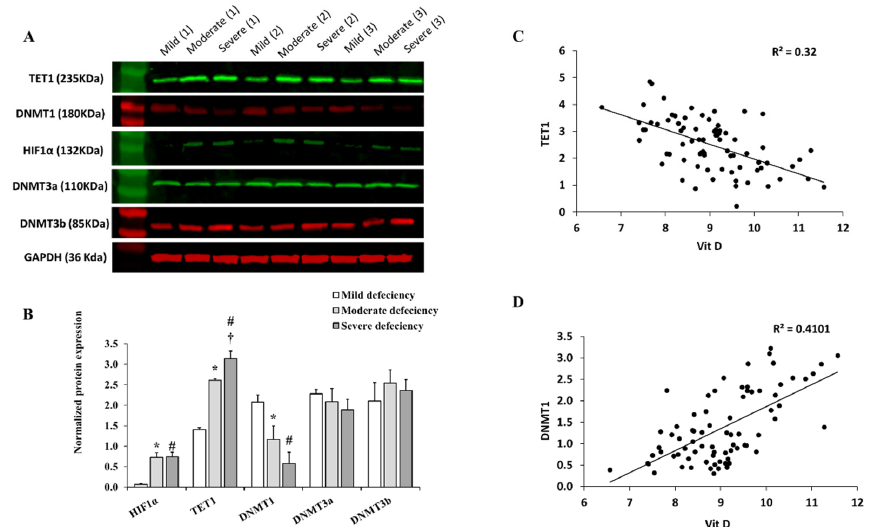
Figure 4. Protein levels of HIF1 α , TET1, and DNMTs in VAT across VD deficiency categories. ( A ) Representative Western blots for analyzing VAT-extracted proteins from 9 subjects (3 per each VD deficiency group); all samples were tested but only 9 were presented in this figure. ( B ) A quantification chart showing the means ± standard error (SE) of the target protein signal intensity normalized to the housekeeping gene, GAPDH. A significant p -value is represented by * for comparing the mild and moderate deficiency groups, # for comparing the mild and severe deficiency groups, and † for comparing moderate and severe deficiency groups. ( C , D ) Scatter plots and R 2 for the correlation between VD concentrations and protein levels of TET1 ( C ) and DNMT1 ( D ).